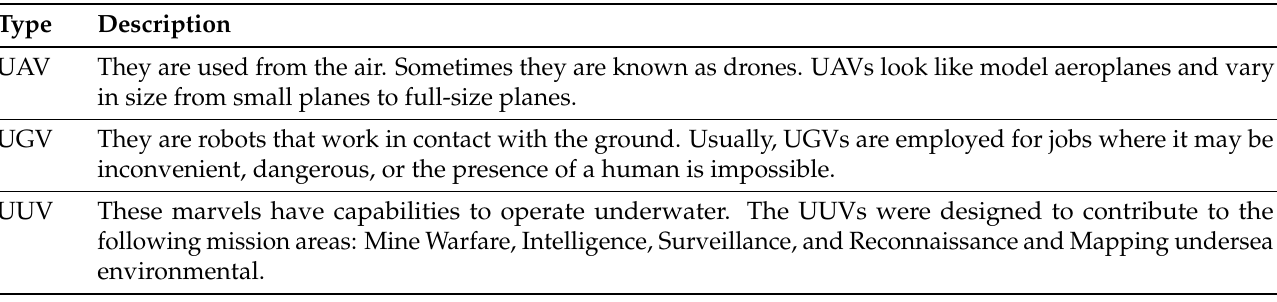
Table 1. Classification of defence robots according to the application environment.